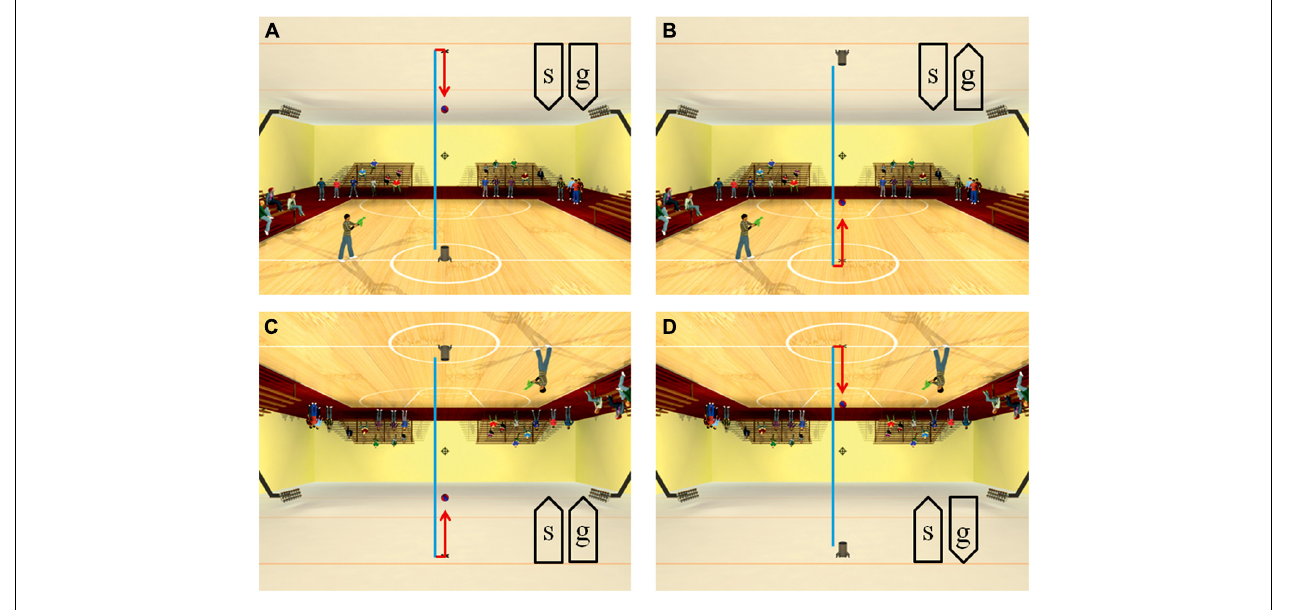
character shot a bullet toward the interception point (indicated by the cross-hair).The direction of the scene (“s”) and the direction of gravity acting on the target (“g”) were varied in different blocks of trials: (A) normal scene and gravity, (B) normal scene and inverted target gravity, (C) inverted scene and gravity, (D) inverted scene and normal target gravity. Modified with permission from Zago etal.